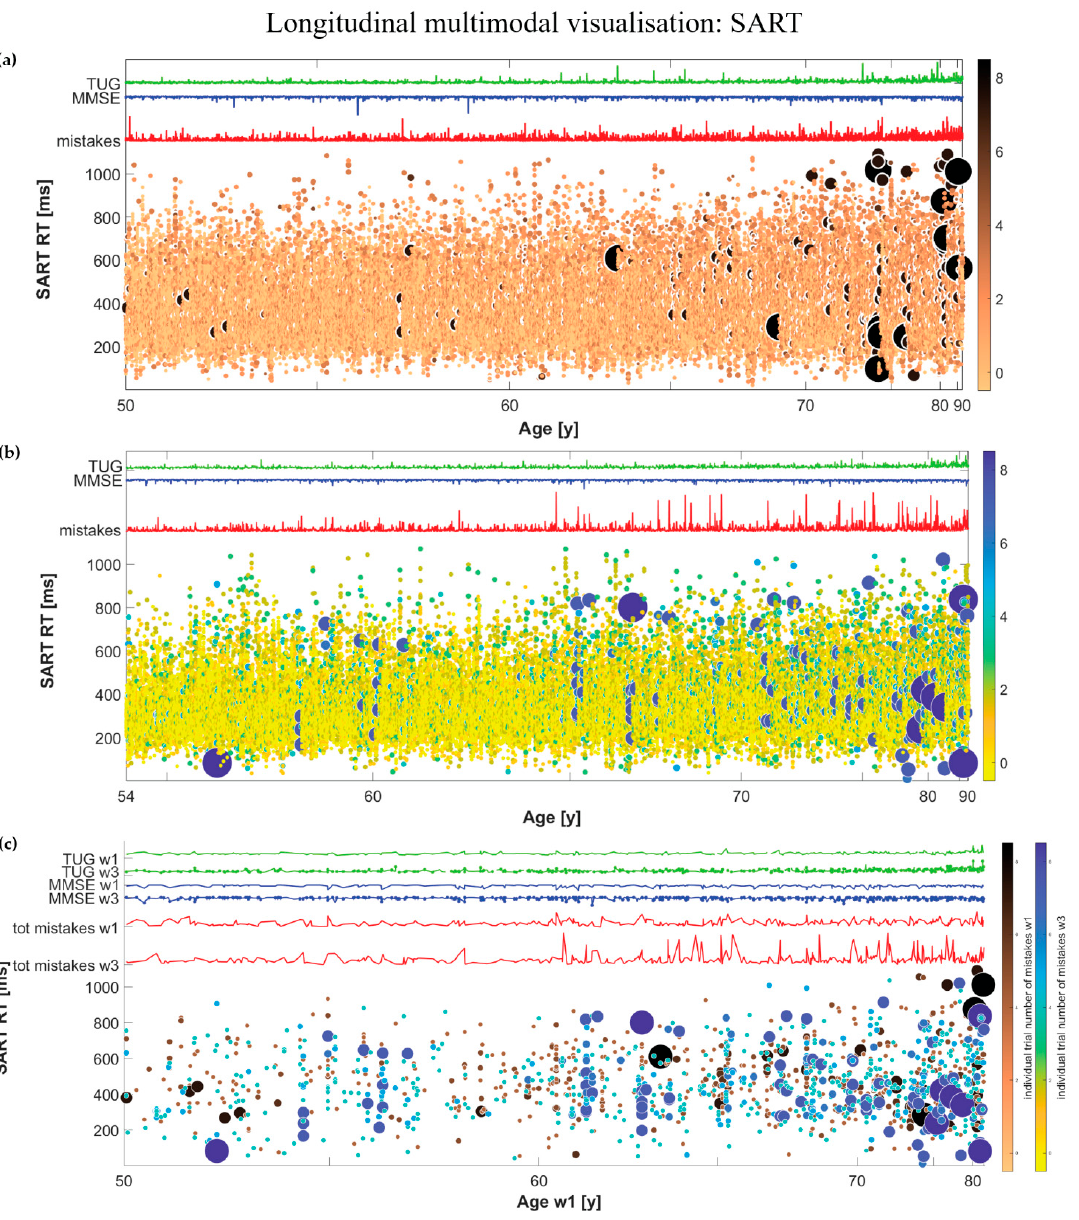
Figure 2. Longitudinal multimodal visualisation of SART data: ( a ) entire cohort at wave 1, ( b ) merged cohort at wave 3, ( c ) only participants with bad performances at wave 1 (dark brown/black big spots) and/or at wave 3 (blue big spots).